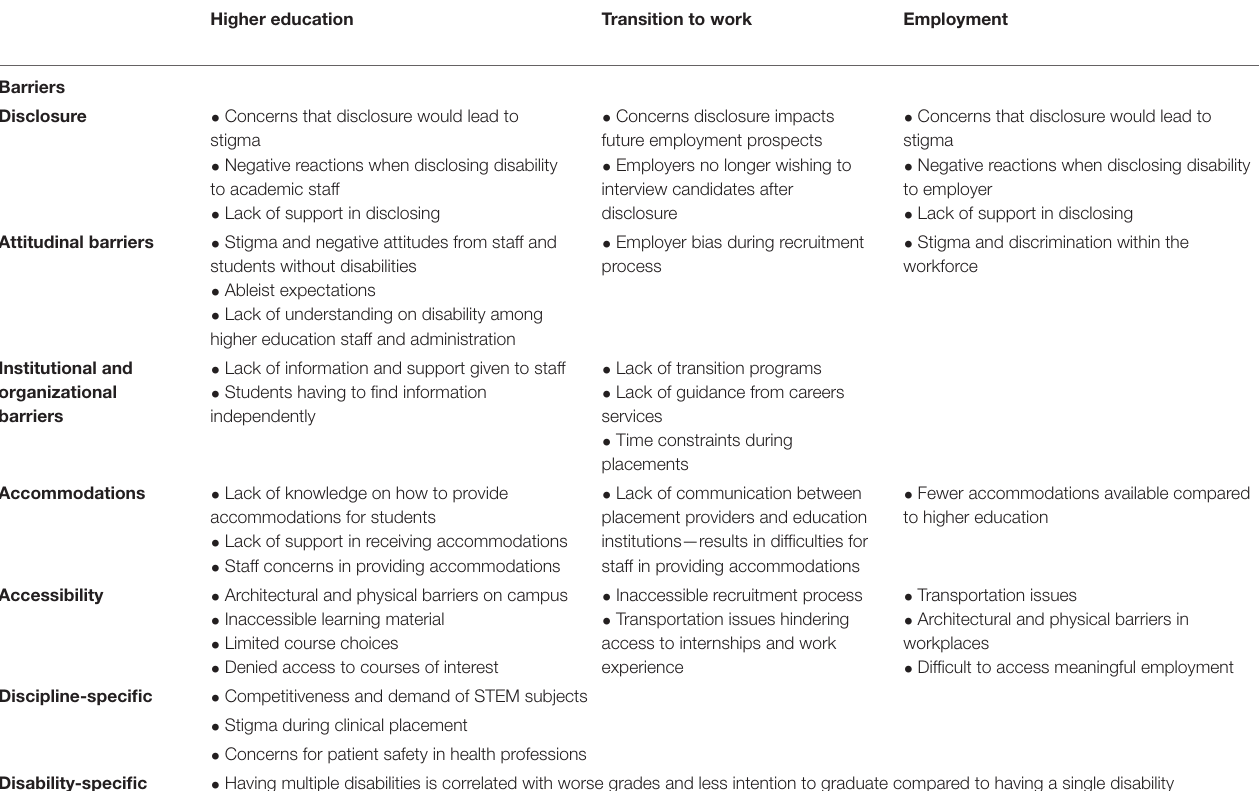
TABLE 2 | Barriers in the transition from higher education to